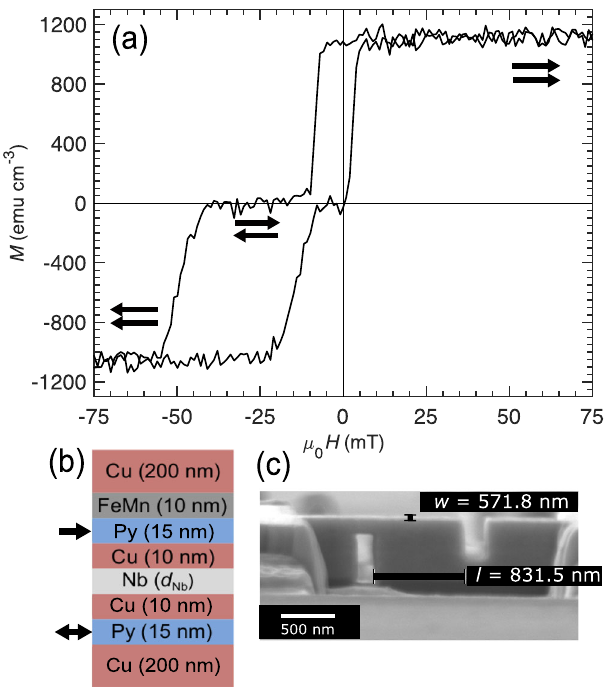
Fig. 1 Magnetic switching characteristics and device heterostructure. a Magnetization ( M ) vs. in-plane magnetic fi eld ( H ) hysteresis loop for an unpatterned spin-valve at 10 K (arrows indicate the net magnetic moment directions of the top and bottom permalloy layers, μ 0 is the magnetic spin-valve with layer thicknesses, including varying Nb thickness d Nb . Arrows represent pinned (top) and free (bottom) ferromagnetic layers. c Scanning electron micrograph of an example nanopillar